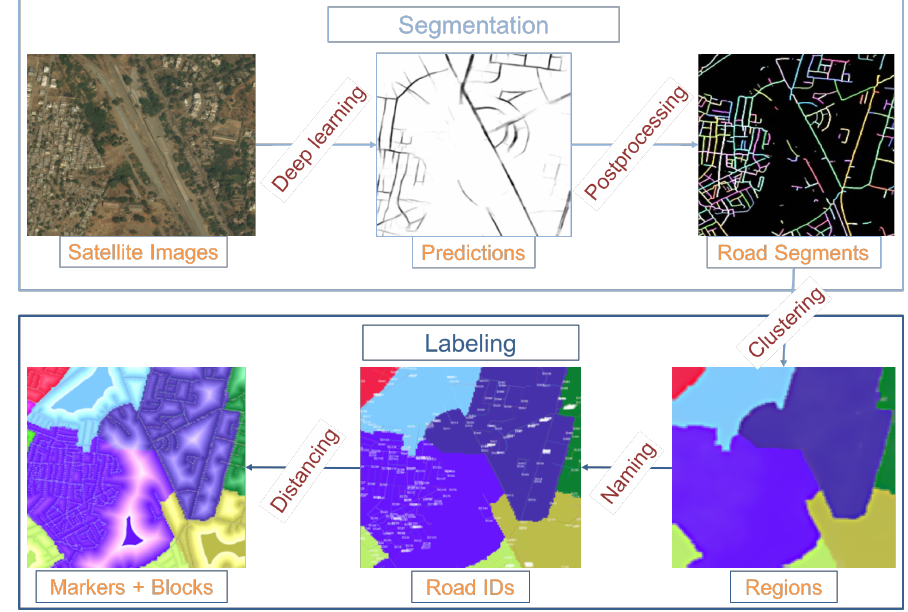
Figure 5. System Pipeline. Our approach is trained on satellite images for predicting roads. Then the road predictions are processed to extract road segments (Section 4.2). The segments are clustered to obtain regions (Section 4.3). The roads are named according to regions and ordering, and the address cells are named according to road-oriented axes (Section